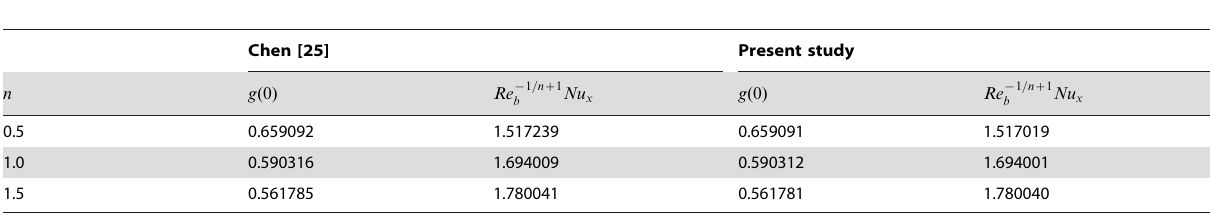
Table 3. A comparison of the local Nusselt number in the PHF